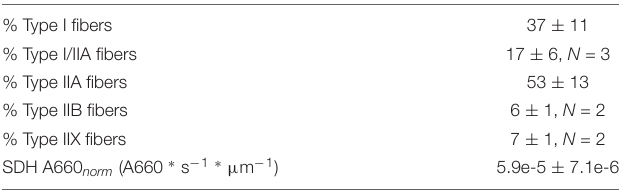
TABLE 2 | Mean ± SD of bundle fiber type distribution, average SDH activity (A660 norm